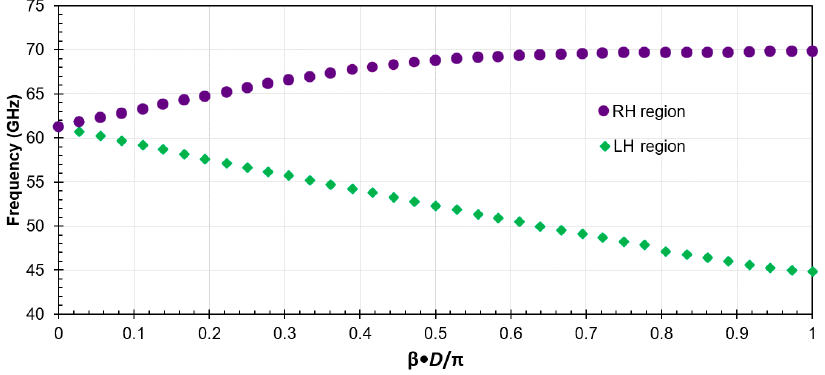
Figure 2. Dispersion diagram of the unit cell of the LWA based on Eigenmode simulations. The frequencies of the Eigenmodes are plotted versus the normalized phase change for the right-handed (RH) region (circles, purple) and the left-handed (LH) region (diamonds, green).